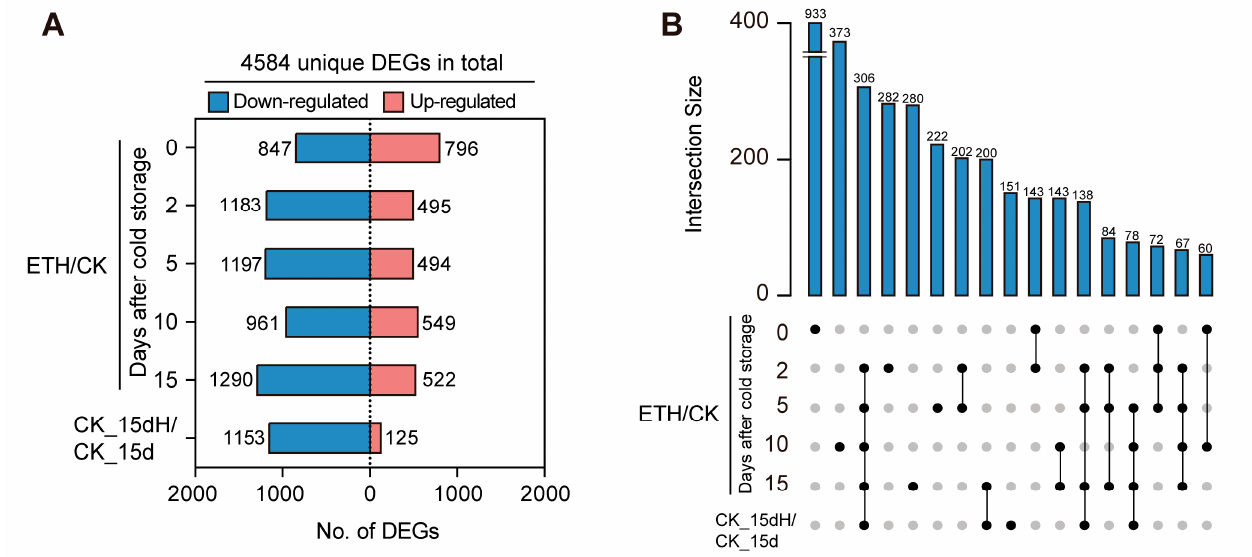
Figure 3. Statistics of differentially expressed genes (DEGs). ( A ) Counts of DEGs for each time point. ( B ) Upset plot illustrating the intersection of DEGs. ( B ) Upset plot illustrating the intersection of